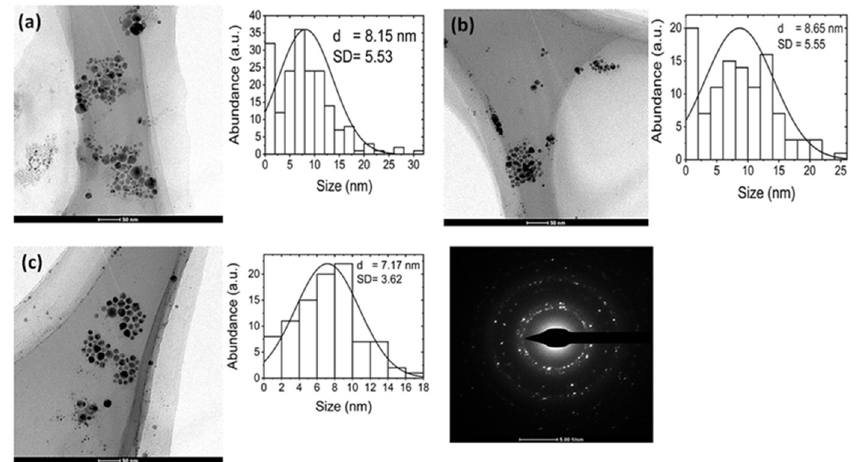
Figure 4. TEM images of ( a ) Au100Ag0, ( b ) Au50Ag50 and ( c ) Au0Ag100 of nanoparticles at 5 min irradiation time.